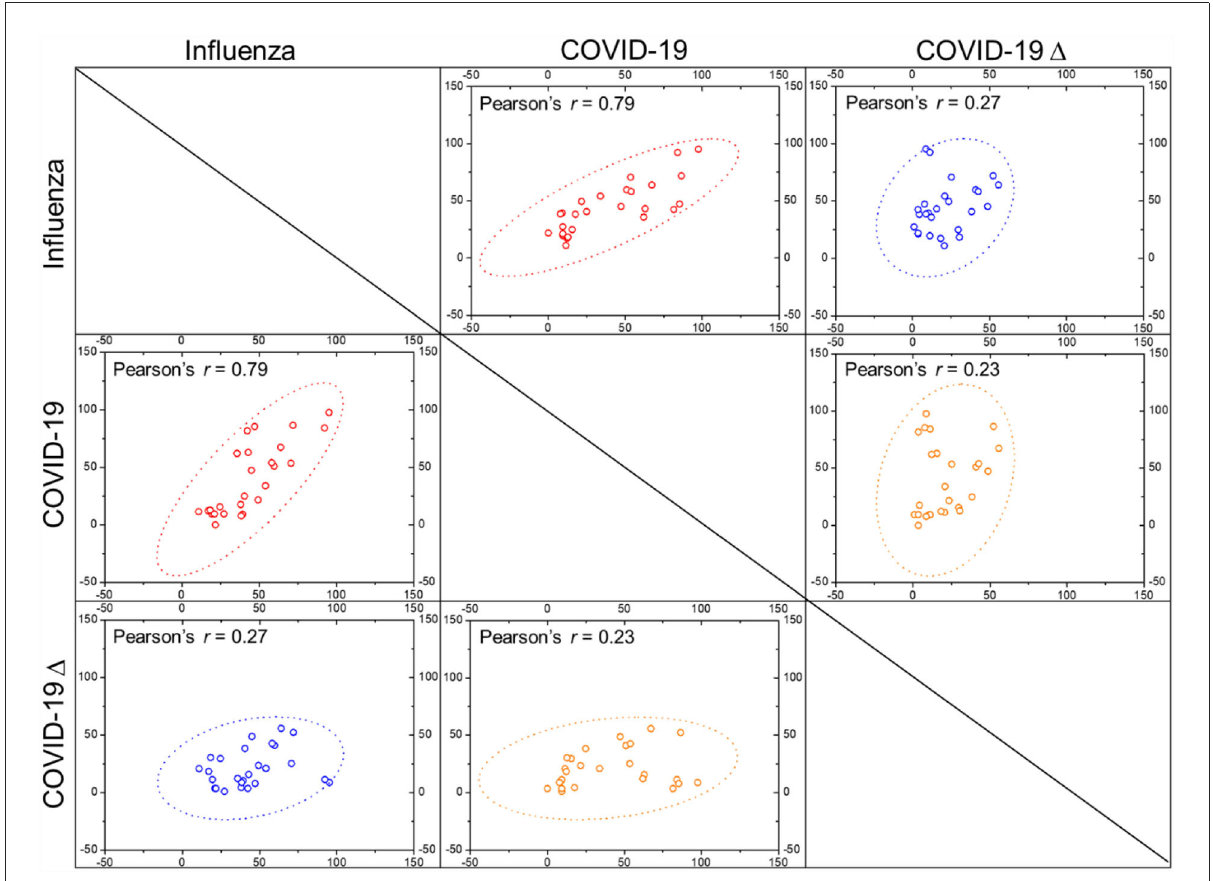
FIGURE1 Pearson’s correlation coefficients ( r values) were calculated between any two cohorts as indicated, with dotted ellipse showing confidence, by using the frequencies of patients with deranged blood characters (scattered dots) as indicated in Table